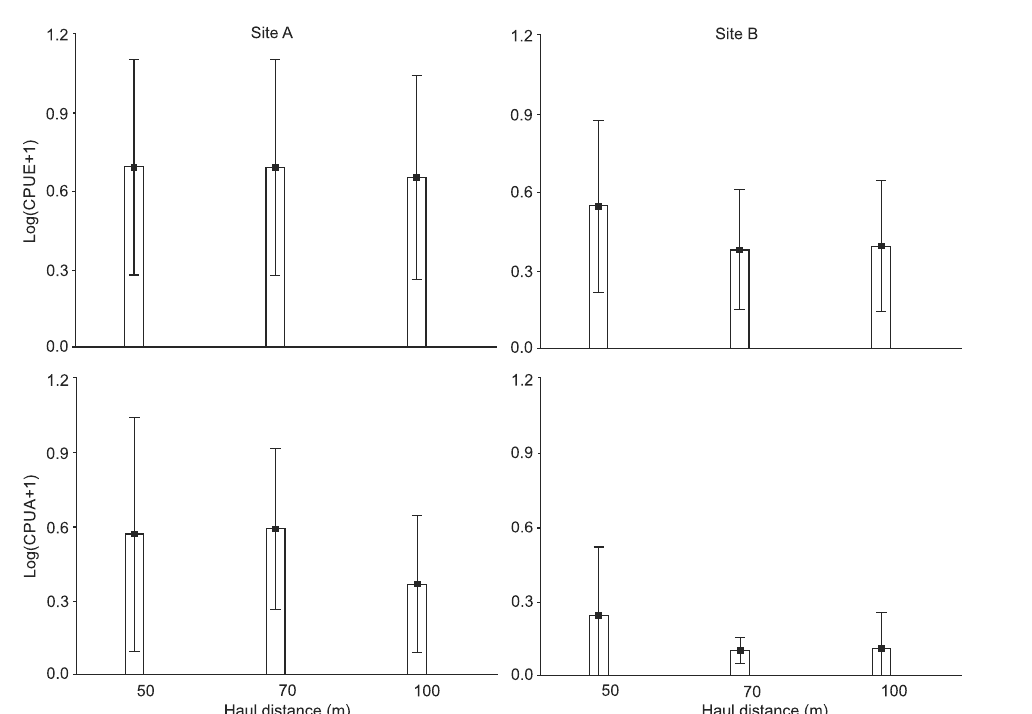
Figure 4. Variations of mean CPUE and CPUA (log transformed) values by haul distance (50, 70 and 100 m) in each site (A and B). The 10 vertical bars indicate the mean values and lines indicate the standard Table I. Total numbers of dominant taxa in each haul distance (50, 70 and 100 m). Taxa were classified as Abundant and Frequent (bold), Frequent and Not-Abundant ( underline), Abundant and rare (italic), and the other ones are present but not frequent or abundant. Site A Taxa